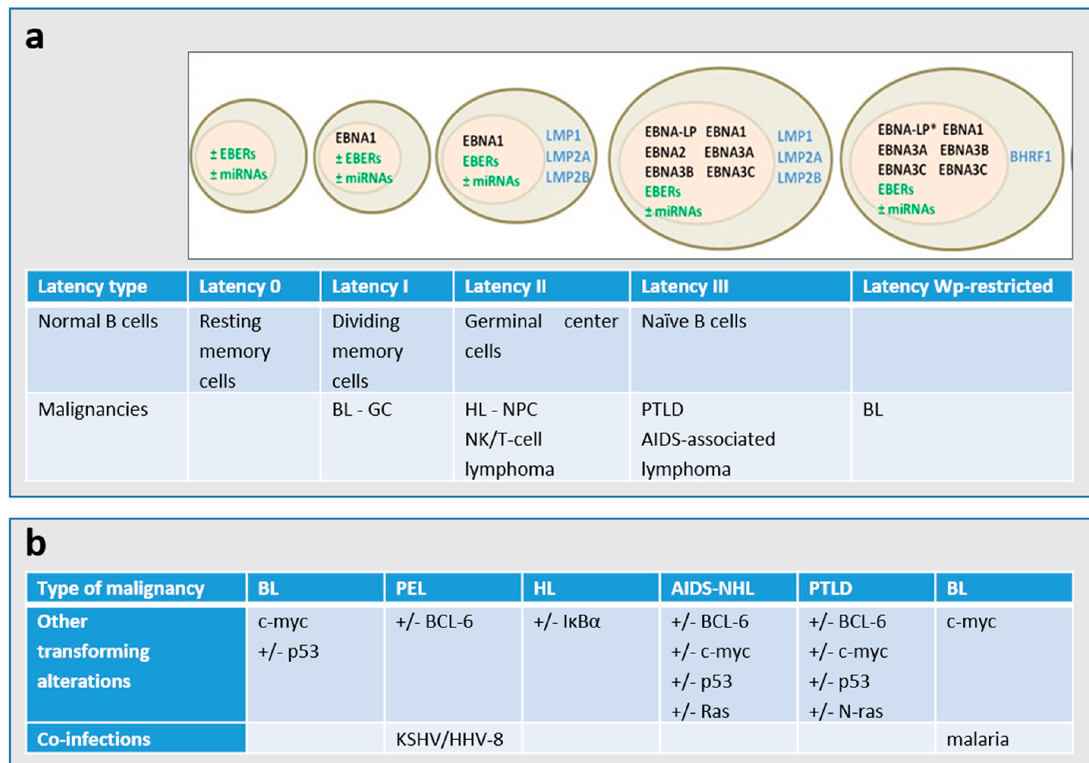
Figure 2. ( a ) Patterns of gene expression during EBV latency. The majority of the endemic BL presents a latency I type and carry a wild-type transformation-competent EBV genome and express only the Epstein–Barr nuclear antigen 1 (EBNA1) from the EBNA1 -specific latent promoter Qp, non-coding EBERs (Epstein–Barr virus-encoded small RNAs) and several microRNAs (miRNAs). Around 15% of BL endemic tumors, the so called Wp-restricted BLs, carry an EBNA2 gene-deleted genome and express EBNA1, -3A, -3B, and-3C and the viral Bcl2 homologue BHRF1 from the Wp latent promoter [2,6]. * The EBNA-LP gene is partially deleted in the Wp-restricted latency. A major type of latency in EBV-associated malignancies is latency II, in which the latent membrane proteins LMP1, LMP2A, and LMP2B are expressed in addition to the Latency I genes. The entire EBV latency gene complex, which consists of several EBNA proteins, LMP1, LMP2A, LMP2B, EBERs, and miRNAs are expressed in the type III latency. ( b ) The cellular genetic alterations and/or co-infections are known to occur in the different types of EBV-associated malignancies. PEL: primary effusion lymphoma; HL: Hodgkin lymphoma; BL: Burkitt lymphoma; NHL: non-Hodgkin lymphoma; PTLD: